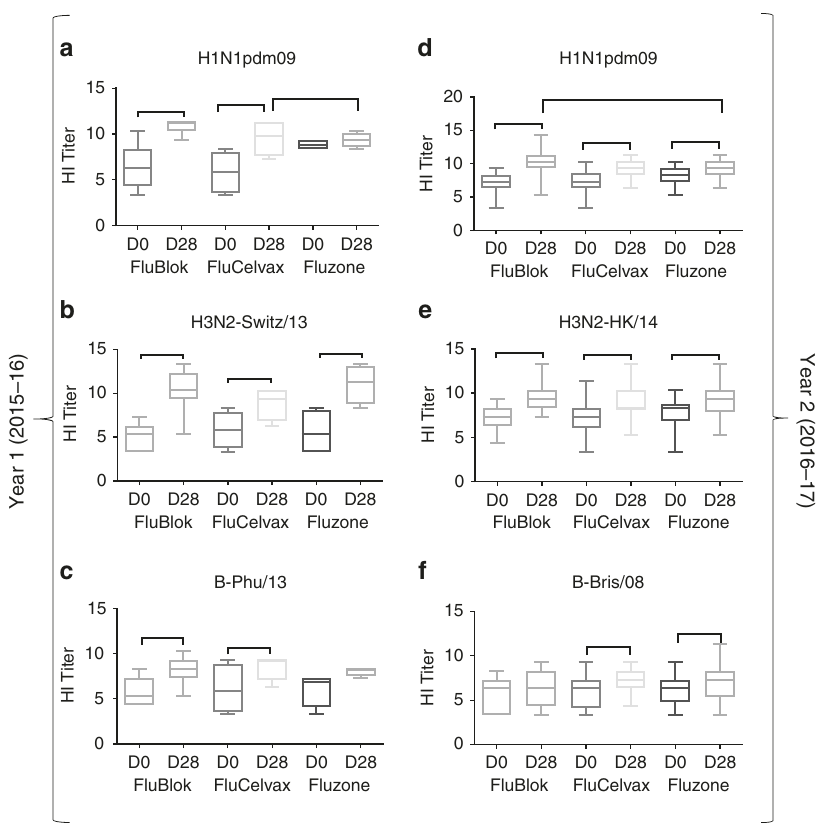
Fig. 1 HI titers following vaccination with FluBlok, FluCelvax, and Fluzone. a – f Average HI titers against H1N1pdm09 ( a , d ), H3N2 ( b , e ), and in fl uenza B ( c , f ) virus strains pre-vaccination (D0) and post-vaccination (D28) are shown for FluBlok, FluCelvax, and Fluzone (excluding repeat vaccinators, see Table 2), in the fi rst (2015 – 2016) year ( a – c ) and second (2016 – 2017) year of the study ( d – f ). The box and whisker plot show the median value and the minimum and maximum values. For the Day 28 post-vaccination HI titers and fold change from Day 0, an ANCOVA model was used for comparison between the vaccine groups, adjusted for gender, age, and baseline (Day 0) values (Supplementary Tables 2 and 3). Statistically signi fi cant differences between groups and pairs are indicated by horizontal bars. Source data are provided as a Source Data fi